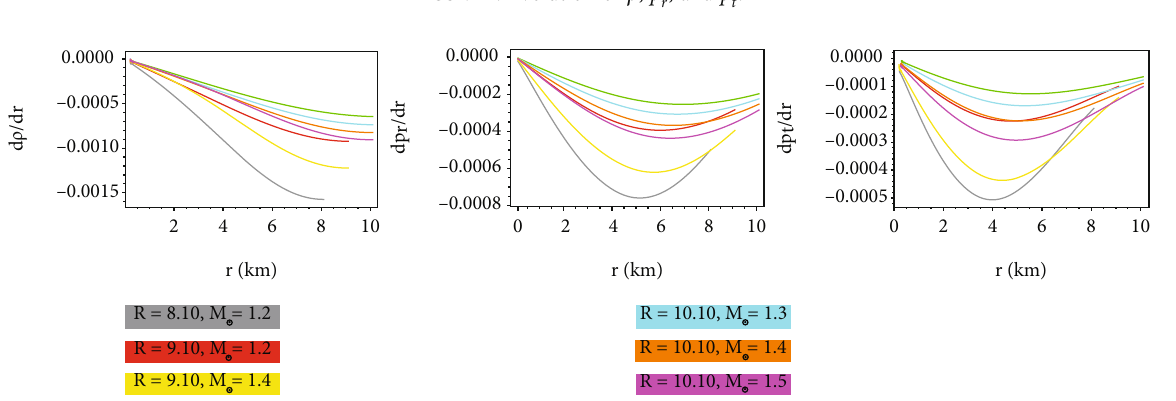
Figure 2: Evolution of ρ , p